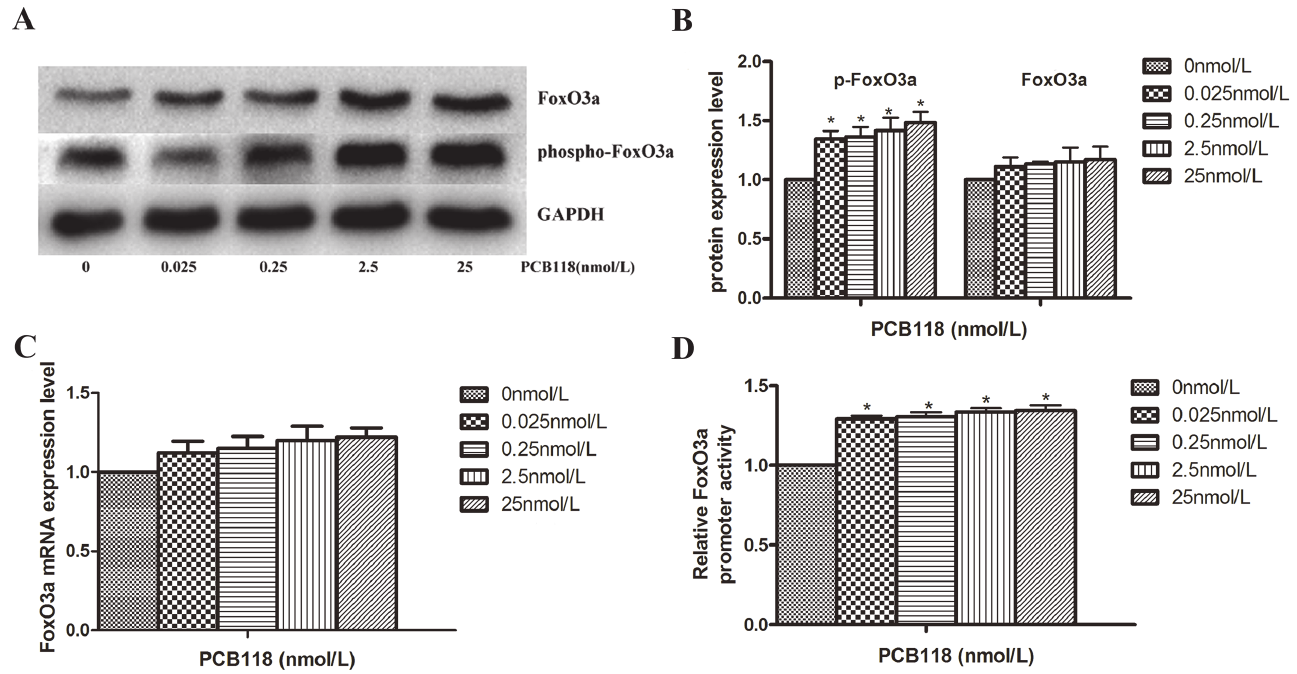
Fig 4. Exposure of FRTL-5 cells to PCB118 results in the up-regulation of FoxO3a or p-FoxO3a expression. Cells were treated with DMSO or various concentrations of PCB118 (0.025 – 25 nM) for 24 or 48 h. Whole cell lysates were analyzed by western blotting using antibodies recognizing FoxO3a and p- FoxO3a. GAPDH served as the loading control (A and B). Total RNA was isolated for qRT-PCR of FoxO3a (C), and the PCB118-treated FRTL-5 cells were harvested for the measurement of FoxO3a promoter activity (D). Results show sections of blots from one experiment of the three that yielded similar results (A) or represent the mean ± SD of three independent experiments (B, C, and D). GAPDH served as the loading control in western blotting. * p < 0.05, compared with the DMSO control group. The relative ratio of target mRNA/ β -actin, target protein/GAPDH and promoter activity in solvent control group was set as